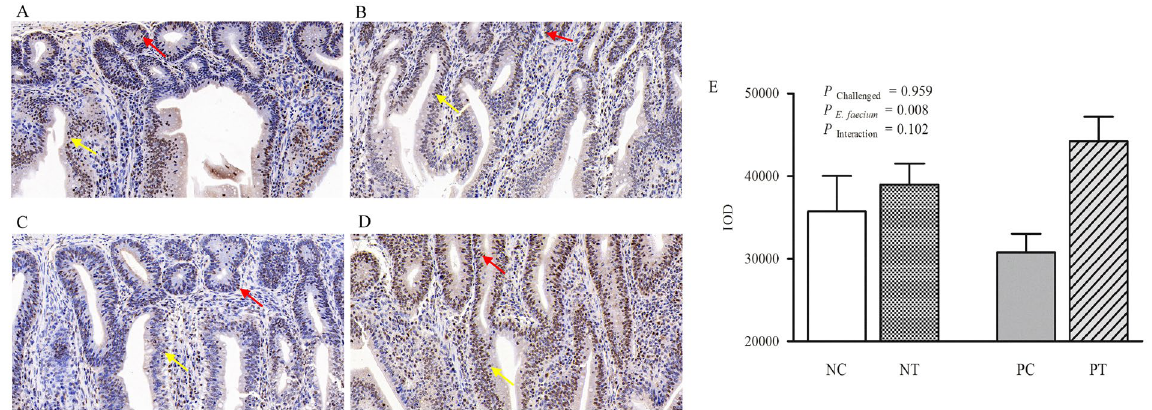
Figure 5. Effect of dietary E . faecium 11181 on the percentage of PCNA-positive cells in the jejunum of broiler chickens challenged with NE at d 26 (7 DPI). PCNA protein expression was assessed in jejunum tissue by immunohistochemistry using the anti-PCNA antibody in ( A ) the NC group, ( B ) the NT group, ( C ) the PC group, and ( D ) the PT group. The red arrow points out a PCNA-positive cell in the jejunal crypt and the yellow arrow points out a PCNA-positive cell in the jejunal villus. ( E ) Integral optical density (IOD) of PCNA expression. Values are means (n = 6) with SEM represented by vertical bars. Magnification = 400 ×